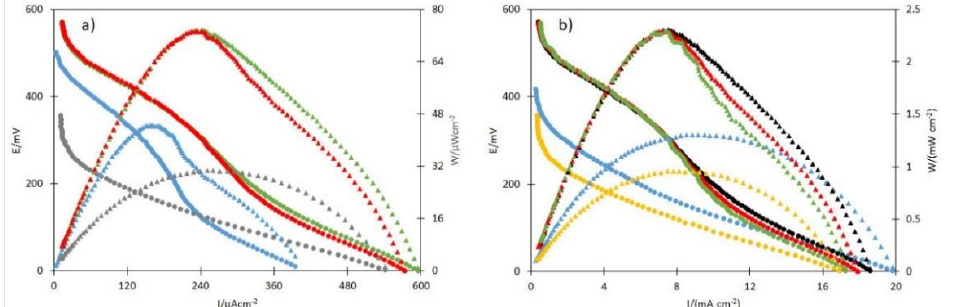
Figure 12. ( a ) Full cell polarization curves of Toray paper anodes modified with Porphyrin/GSH- CdTeQD/GOx, evaluated in PBS 0.1 M pH 7.4, in the presence of FcMeOH ( a ) at a 6 mL h − 1 flow rate. The glucose concentration in the anolyte was 0 mM (gray), 10 mM (blue), 20 mM (green), or 50 mM (red); and ( b ) at different flow rates of the anolyte and catholyte: 1 mL h −1 (yellow), 3 mL h −1 (blue), 6 mL h −1 (black), 9 mL h −1 (red), and 12 mL h −1 (green).